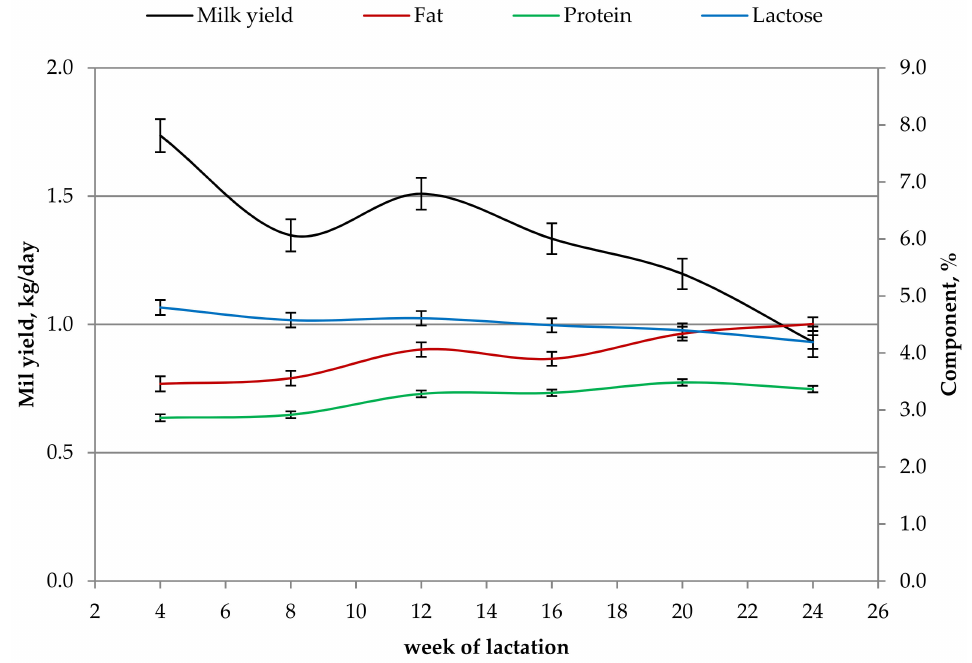
Figure 1. Least squares means (with standard error) of goat milk yield (black line), and fat (red line), protein (green line), and lactose (blue line) percentages throughout